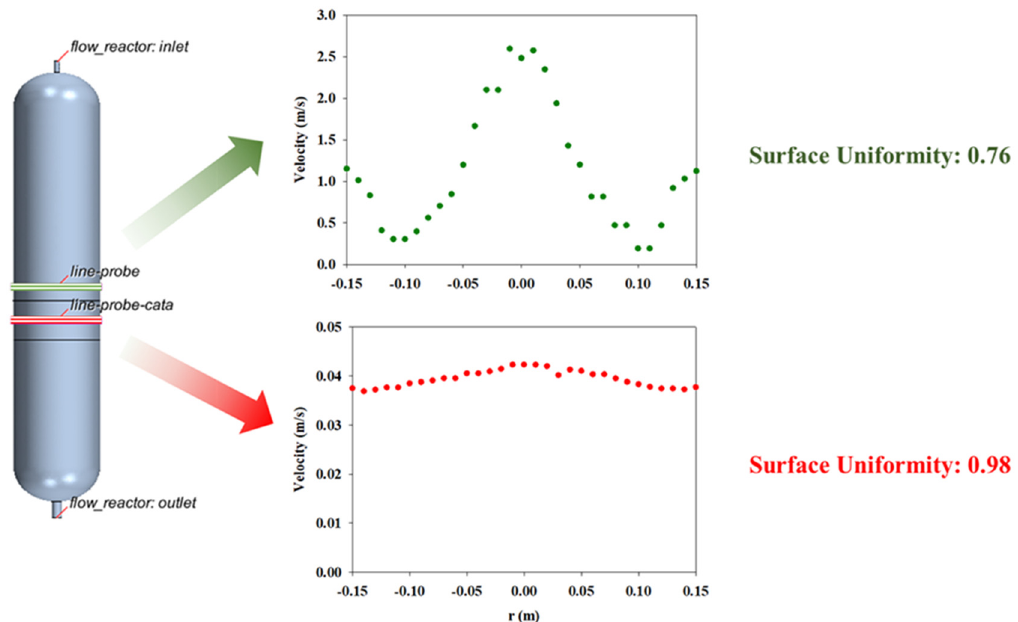
Figure 4. Hot − flow simulation result of the B − type reactor.